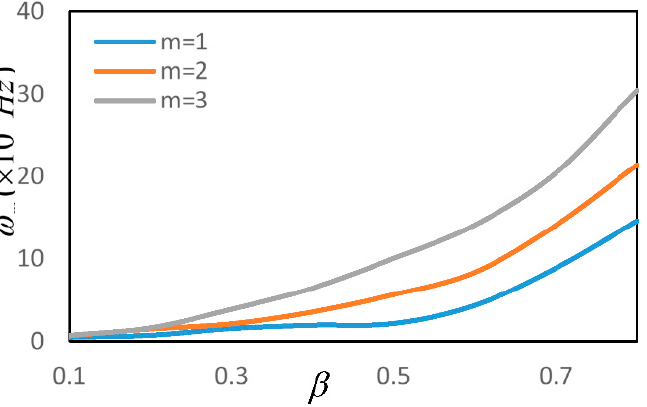
Figure 5. The relation of angular frequency parameter and radii ratio of four-layered annular circular plates with ply orientation 45 0 / − 30 0 /30 0 / − 45 0 ( AGE / EGE / EGE / AGE ) : ( a ) C e = 0.2; ( b ) C s = 0.5; ( c ) η = 1.5; n = 2 and γ = 0.05.